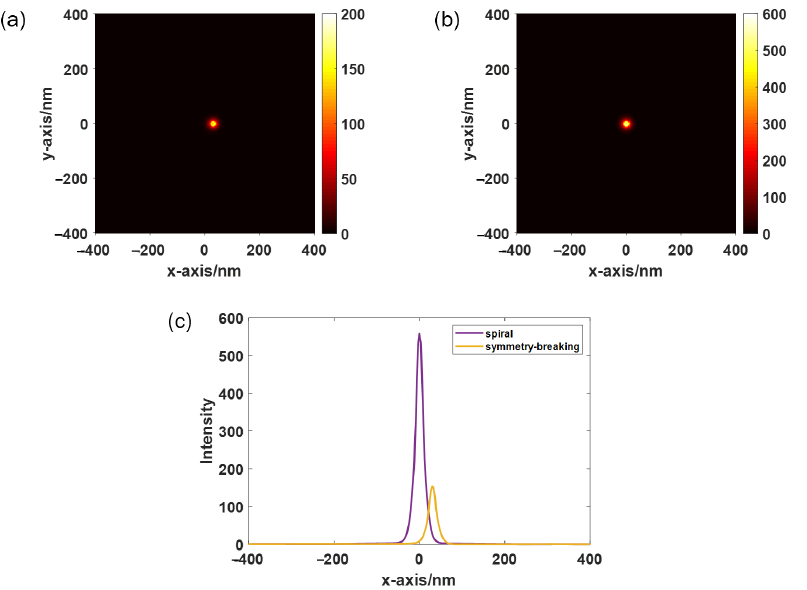
Figure 6. Distribution of the local electric field intensity when the probes are located 10 nm above the focus formed by the ( a ) symmetry-breaking PL and ( b ) spiral PL. ( c ) Distribution of normalized total electric field strength and longitudinal electric field strength along y = 0.